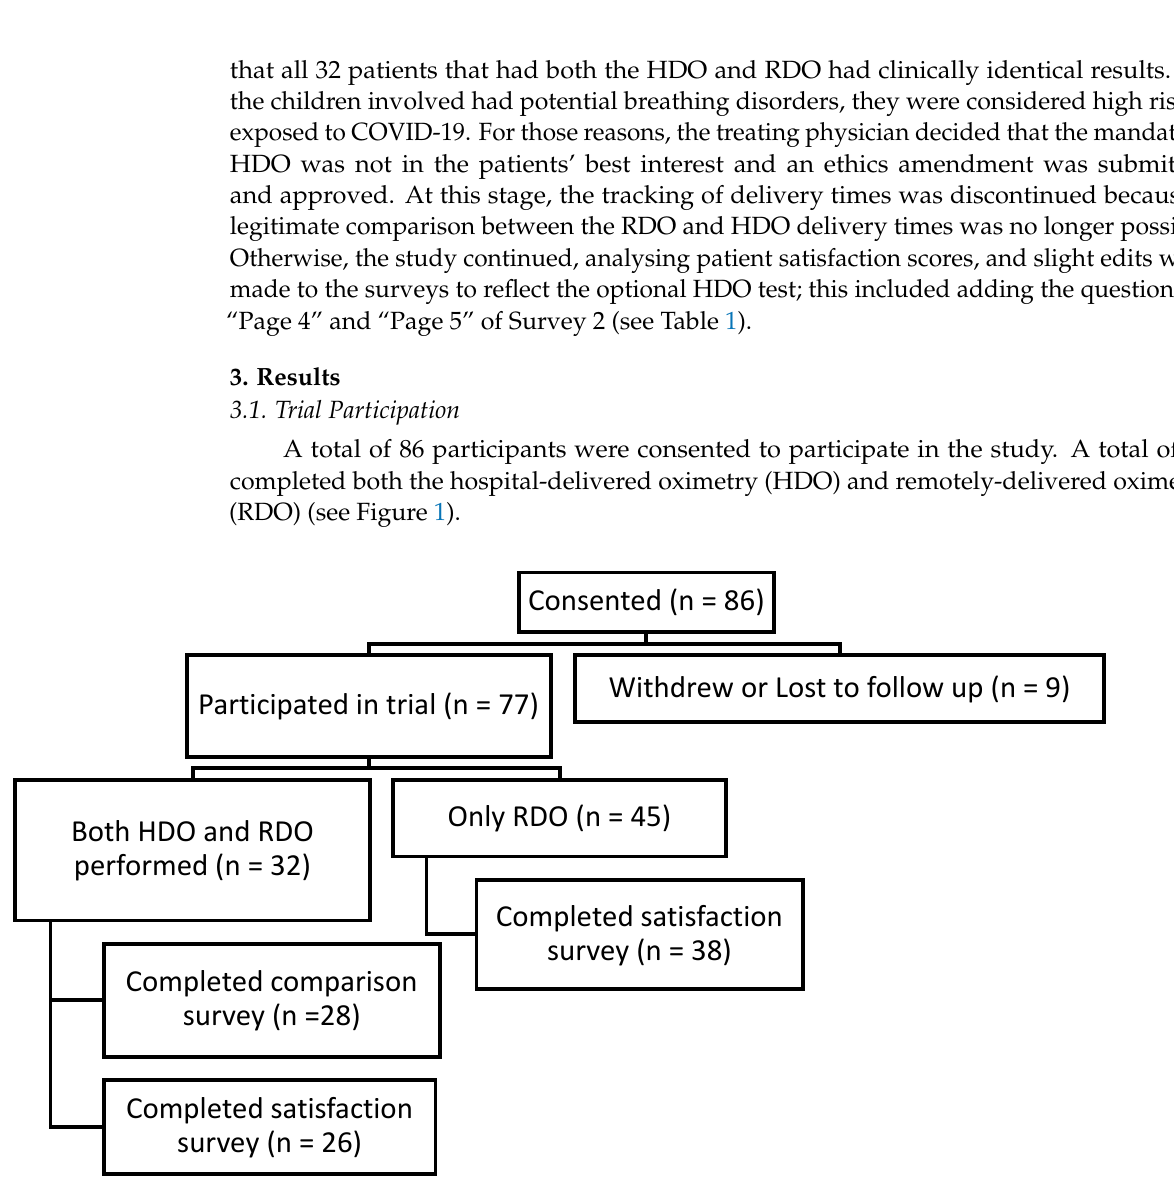
Figure 1. Trial participation: An overview of the participants in the trial; n = the number in each category.